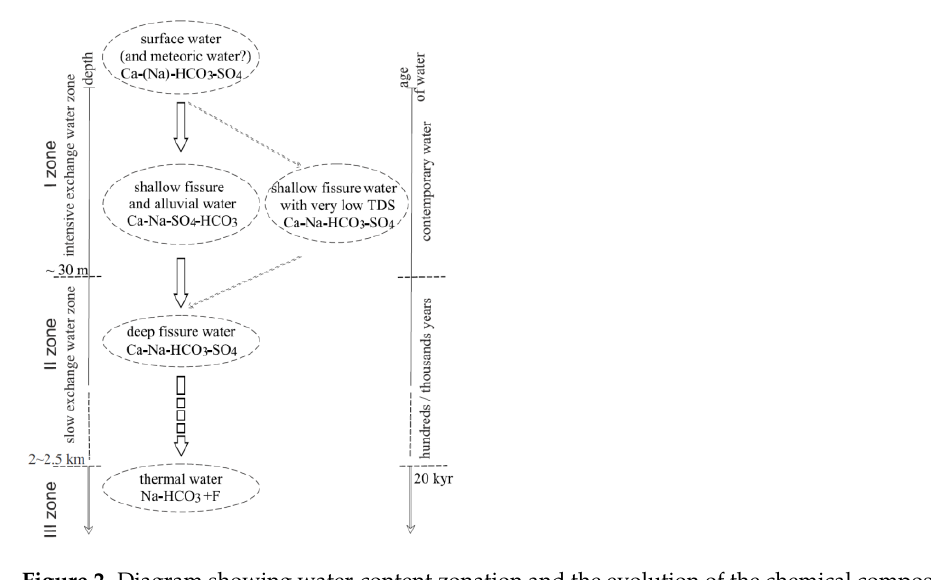
Figure 2. Diagram showing water-content zonation and the evolution of the chemical composition of groundwaters in a depth profile of the Śnieżnik massif (based on [63]).